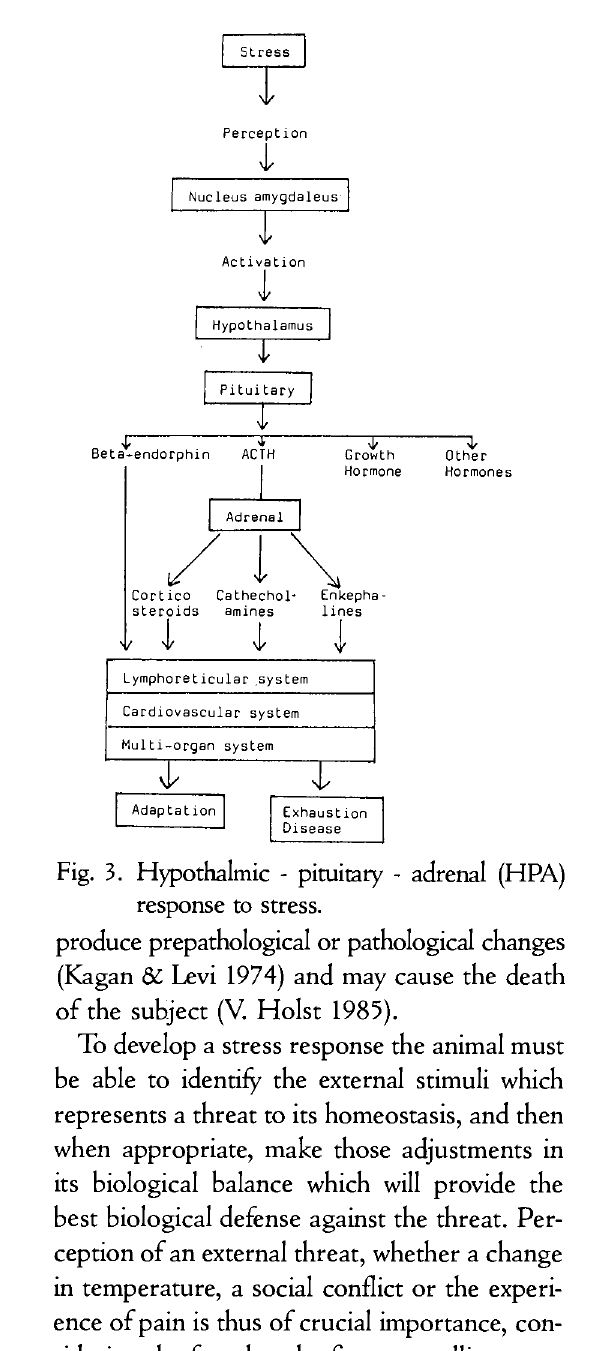
Fig. 3. Hypothalmic - pituitary - adrenal (HPA) response to